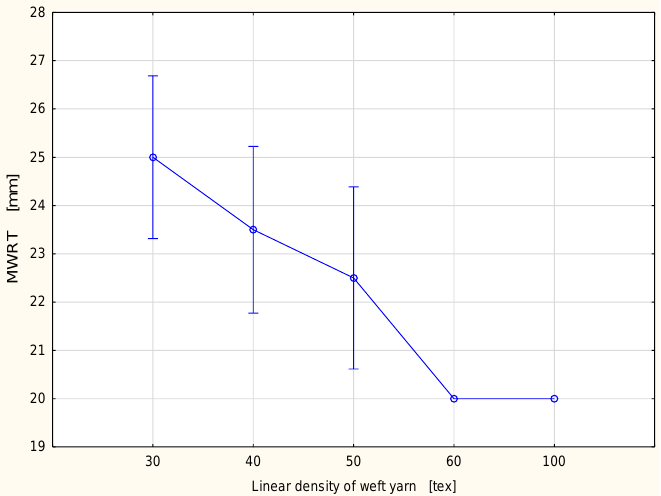
Figure 10. Maximum wetted radius for the top fabric surface vs. linear density of the weft yarn.